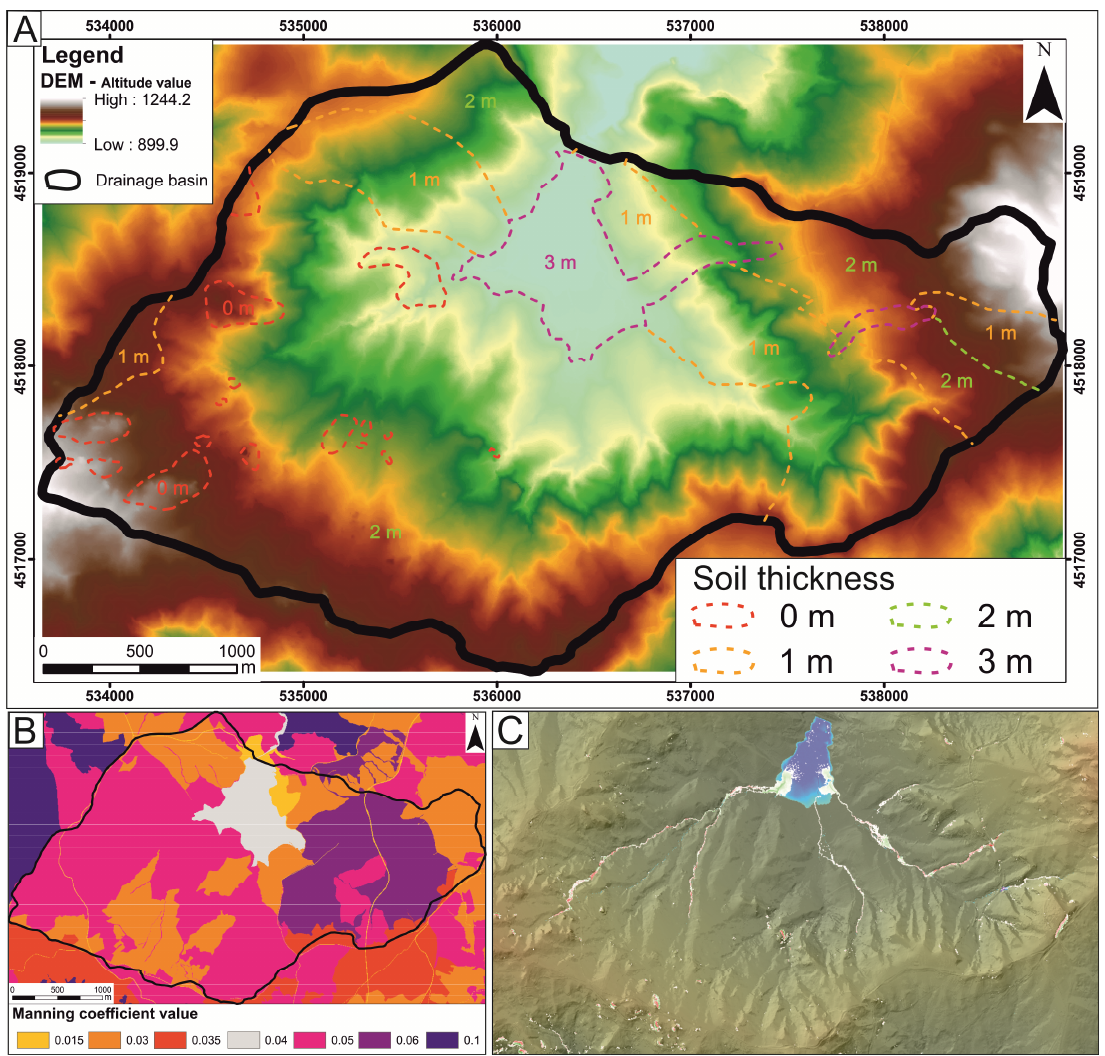
Figure 6. Examples of the input and output data of the Caesar-Lisflood simulation scenario. ( A ) Digital elevation model (DEM) of the study area (spatial resolution: 5 m) and isopachs of the soil thickness extracted by geostatistical interpolation of the field-survey measurements. ( B ) Spatial distribution of the Manning coefficient values deriving by the land use map. ( C ) Intermediate output of the simulation (31 December 1995) showing: (i) the river water levels (white tones); (ii) erosion (red tones) and deposition (green tones) pattern; (iii) reservoir water level (blue tones).